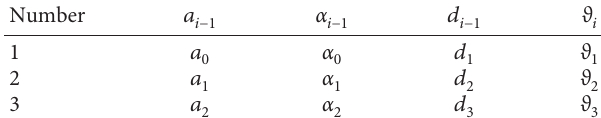
Table 1: D-H model parameters.